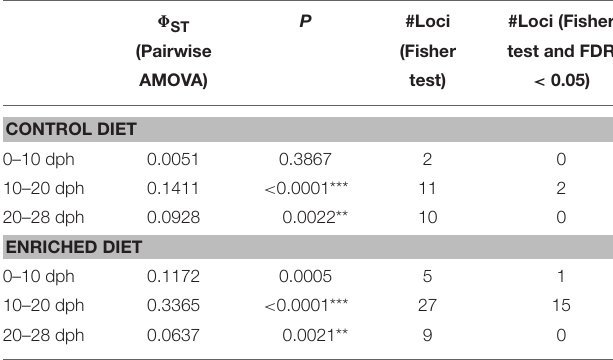
Pairwise AMOVA between adjacent ages was analyzing separately for control and enriched diets. Identification of specific loci by Fisher’s test and False Discovery Ratio adjust (P < 0.05 and FDR < 0.05). ** Indicate significant differences between treatments at the same age (P < 0.01). *** Indicate significant differences between treatments at the same age (P < 0.001). 8 ST Analysis of molecular variance 8 ST genetic differentiation (Excoffier et al., 1992). # Number